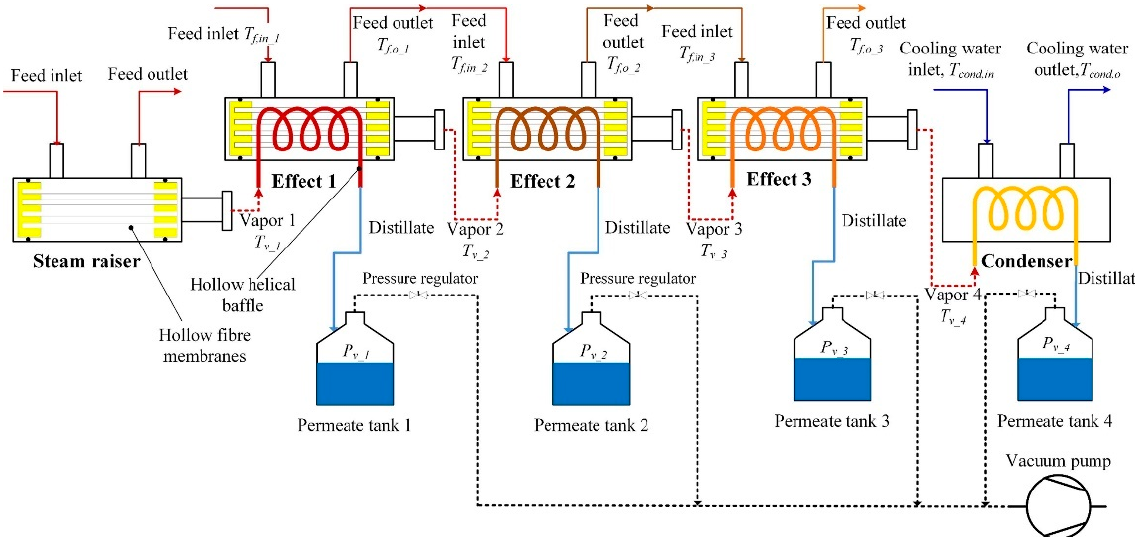
Figure 17. Schematic diagram of a three-effect HF V-MEMD system (the solid lines illustrate the liquid, while the dashed lines denote the vapor). Reprinted from [112] Copyright (2020) with permission from Elsevier.